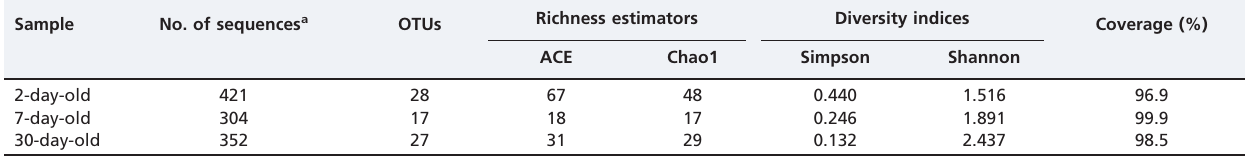
Table 2 - Richness estimators, diversity indices, and coverage of bacterial 16S rRNA gene sequences from 2-, 7-, and 30- day-old neonates (the OTU was defined as a $ 95% similarity cutoff).